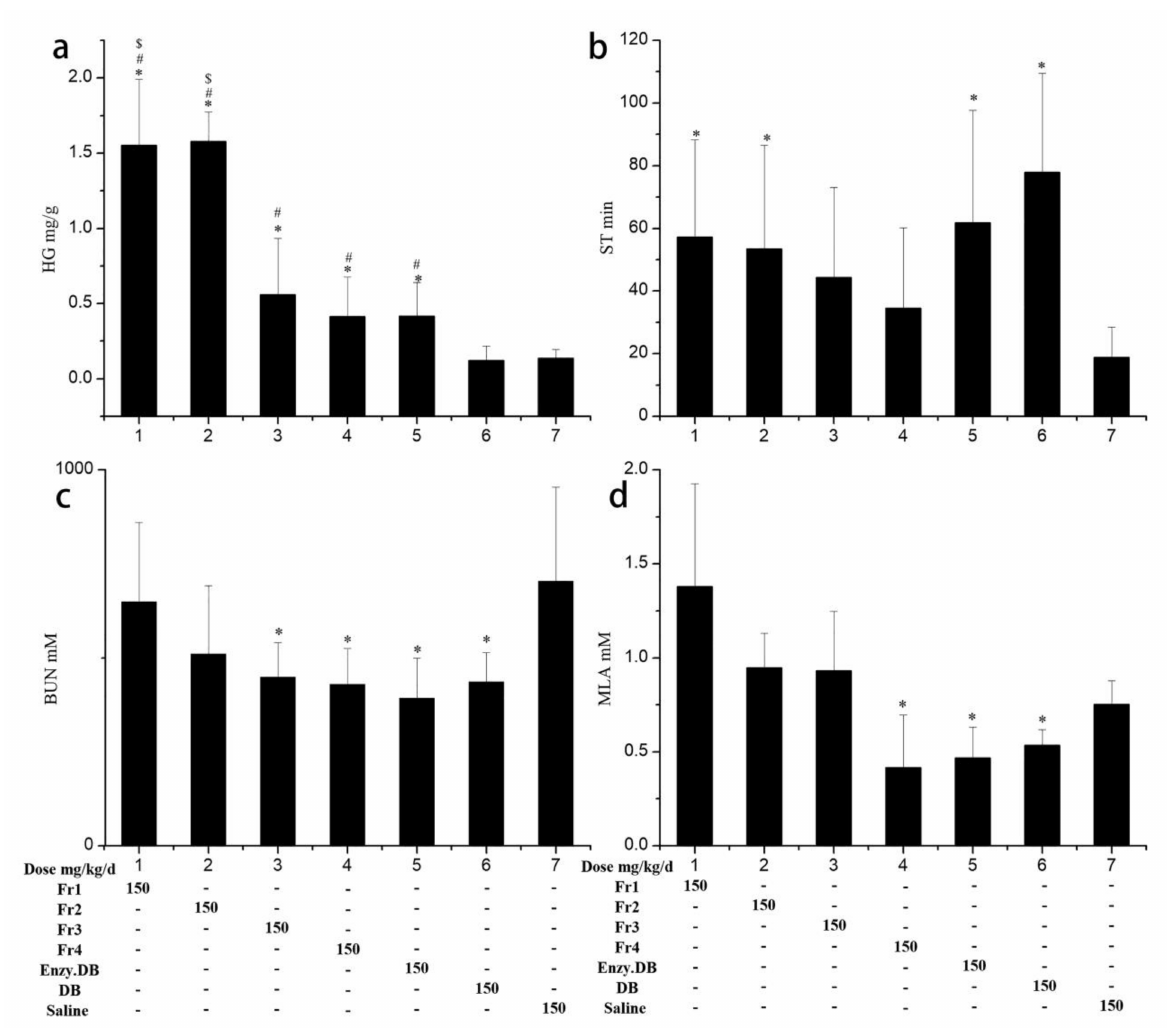
Figure 2. Hepatic glycogen (HG) ( a ), swimming to exhaustion time (ST) ( b ), blood urea nitrogen (BUN) ( c ), and muscle lactic acid (MLA) ( d ), of mice loaded with a lead sheet (5% of their body weight) swimming in 25 ◦ C water (swimming time for BUN, MLA and HG was 18 min) for each of the 7 groups of mice (see text for treatment explanation). Data are expressed as means ± SD (n = 8). * p < 0.05, compared with the saline group. # p < 0.05 compared with the DB group. $ p < 0.05 compared with the deer blood (DB) hydrolysates